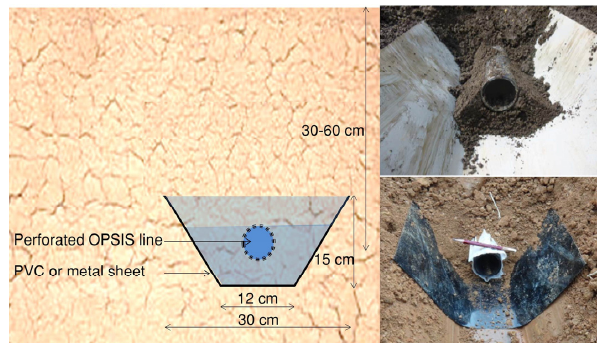
Figure 7. Use of polyvinyl chloride or metal sheet to control percolation losses.